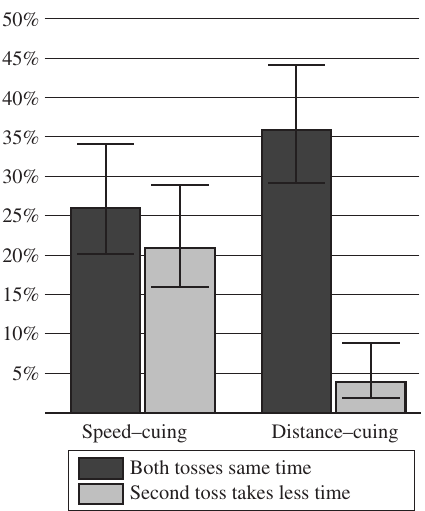
FIG. 6. Distribution of incorrect answers for vertical toss ques- tions with 95% confidence